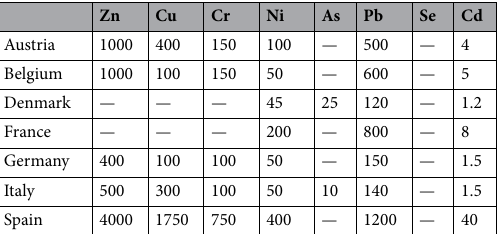
Table 3. Heavy metal limits in fertilizer established by some European Union countries (mg/kg). ‘—’ means the standard of relevant heavy metal concentrations have not been